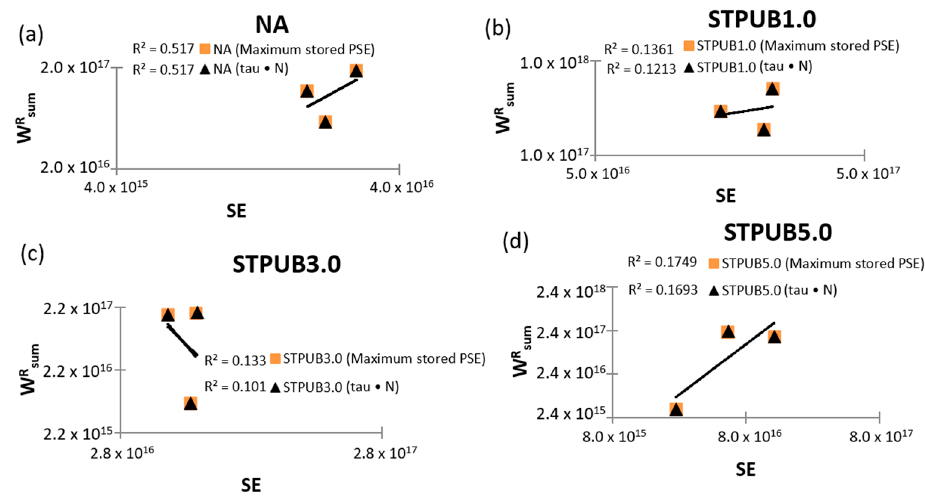
Figure 13. 𝑊 𝑠𝑢𝑚𝑅 – SE failure criterion graphs: ( a ) NA, ( b ) STPUB1.0, ( c ) STPUB3.0, and ( d ) STPUB5.0.